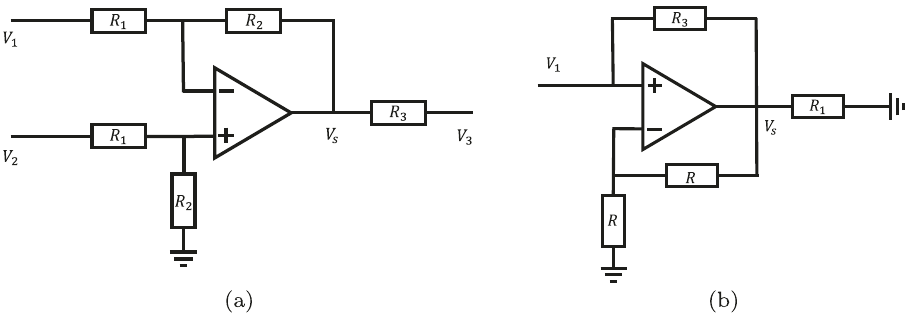
Fig. 7 Active non-Hermitian constituents of the non-Hermitian Hopf link nodal knot circuit. ( a ) Differential ampli fi er and ( b ) negative resistor are the active non-Hermitian elements used in the circuit realization of the non-Hermitian Hopf link nodal knot